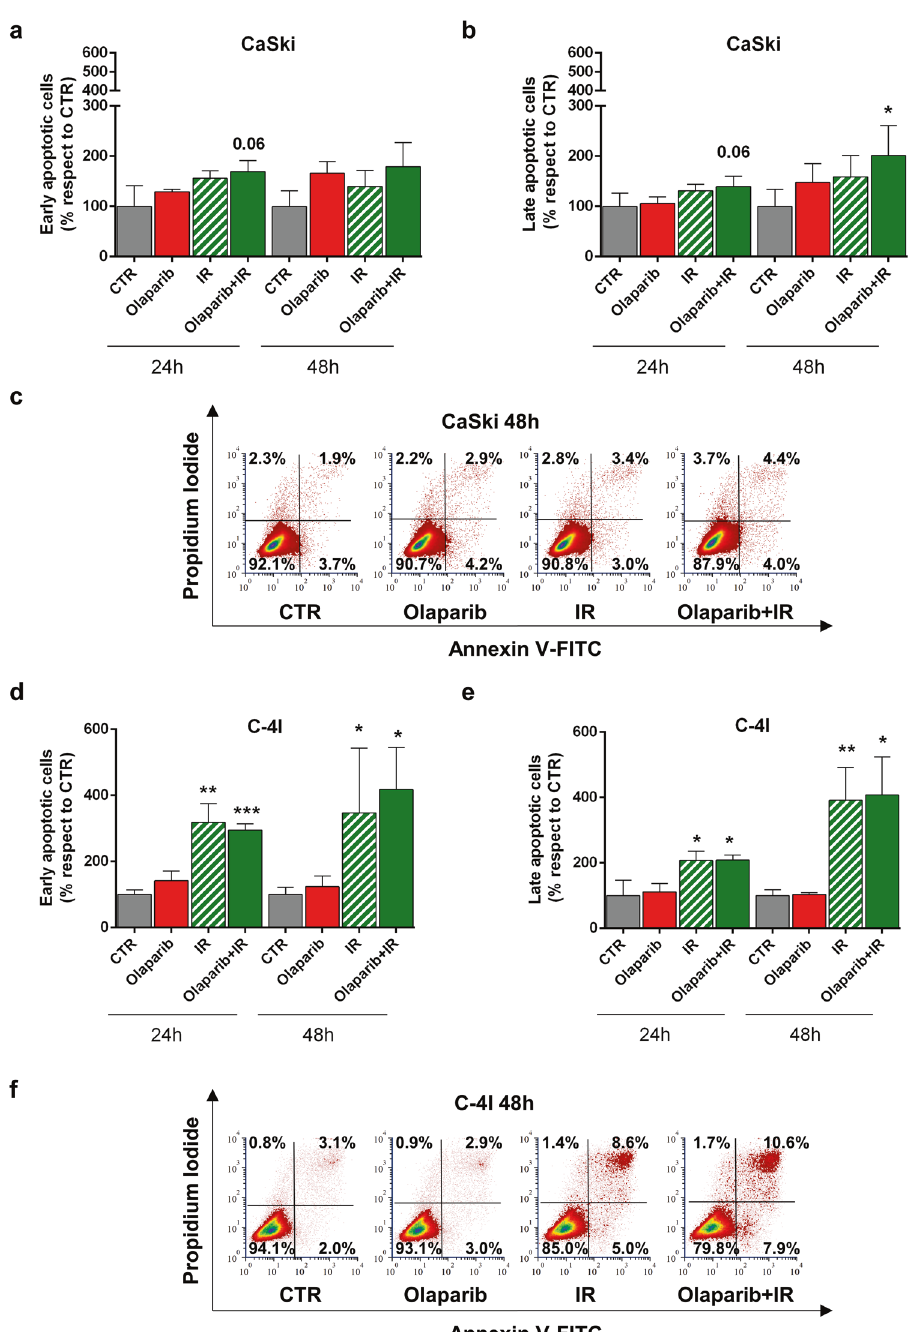
Fig. 4 Olaparib effects on apoptosis of cervical cancer cells. Flow cytometry analysis of CaSki ( a – c ) and C-4I ( d – f ) cells stained with Annexin V and propidium iodide (PI). Bar graphs show percent variation of cells in early (Annexin V + /PI − , a and d ) and late (Annexin V + /PI + , b and e ) apoptosis with respect to CTR after 24 and 48 h treatment of Olaparib (0.7 µM) with or without IR (2 Gy) (mean ± SD, n ≥ 3). Cells were pretreated for 1 h with Olaparib and then irradiated. For each cell line, representative plots obtained by fl ow cytometric analysis at 48 h posttreatment are also shown ( c and f Caski and C-4I cervical cancer cells, respectively). Statistical signi fi cances have been evaluated through an unpaired t -test. * P < 0.05, ** P < 0.01, and *** P < 0.001 respect to CTR. CTR